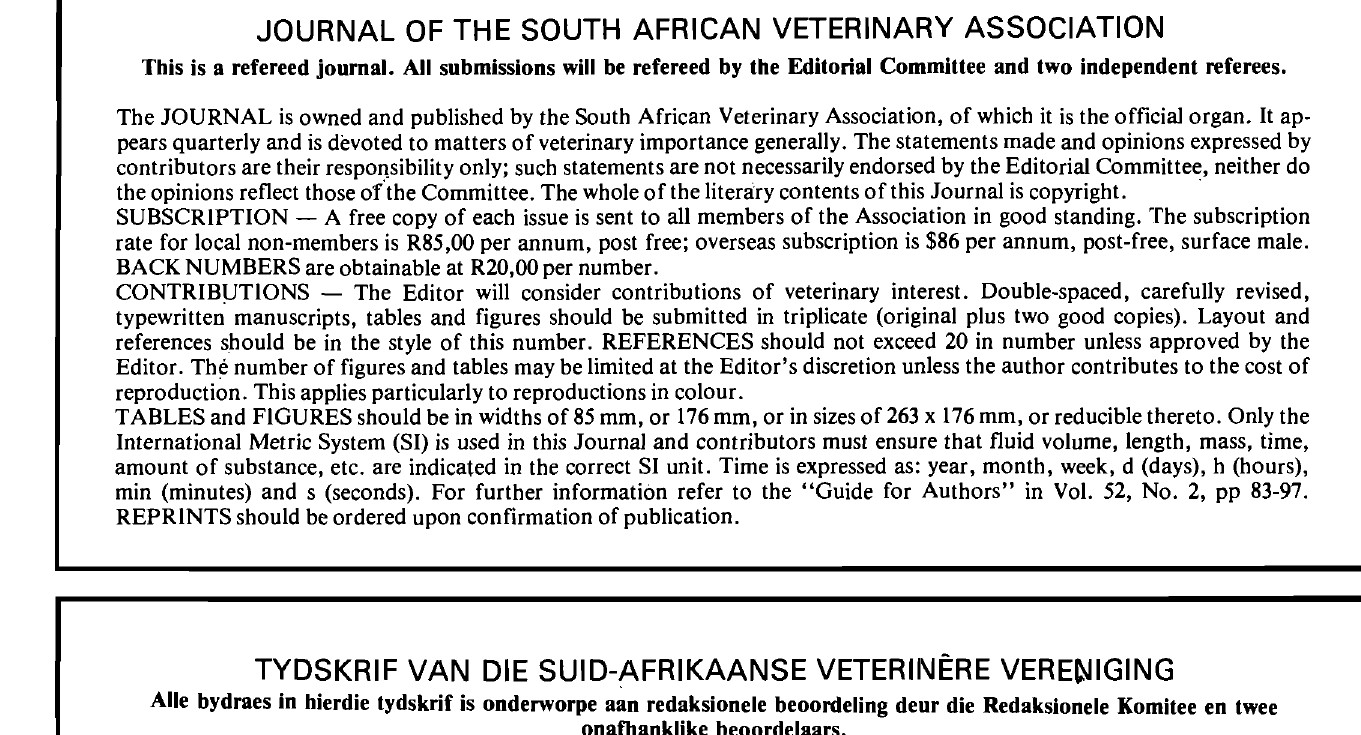
TYDSKRIF VAN DIE SUID-AFRIKAANSE VETERII\lERE VERE~IGING Aile bydraes in hierdie tydskrif is onderworpe aan redaksionele beoordeling deur die Redaksionele Komitee en twee onafhanklike